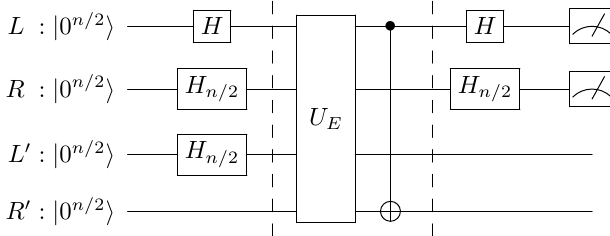
Figure 8: Quantum circuit Q S for a Simon -distinguisher on 3-round Feistel. The H and CNOT gate on the first register are applied only on the first qubit.